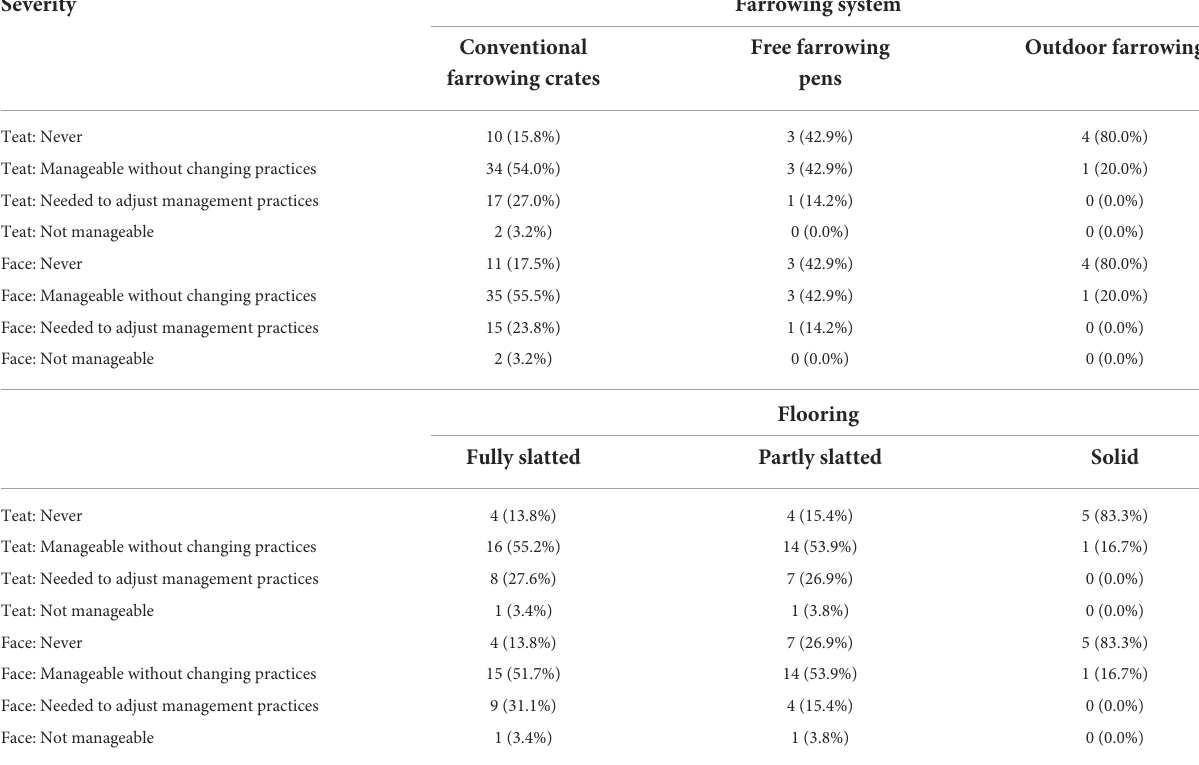
TABLE 6 The reported severity of sow teat (teat) and piglet facial (face) lesions according to the farrowing system and floor type in the farrowing accommodation. Severity Farrowing system